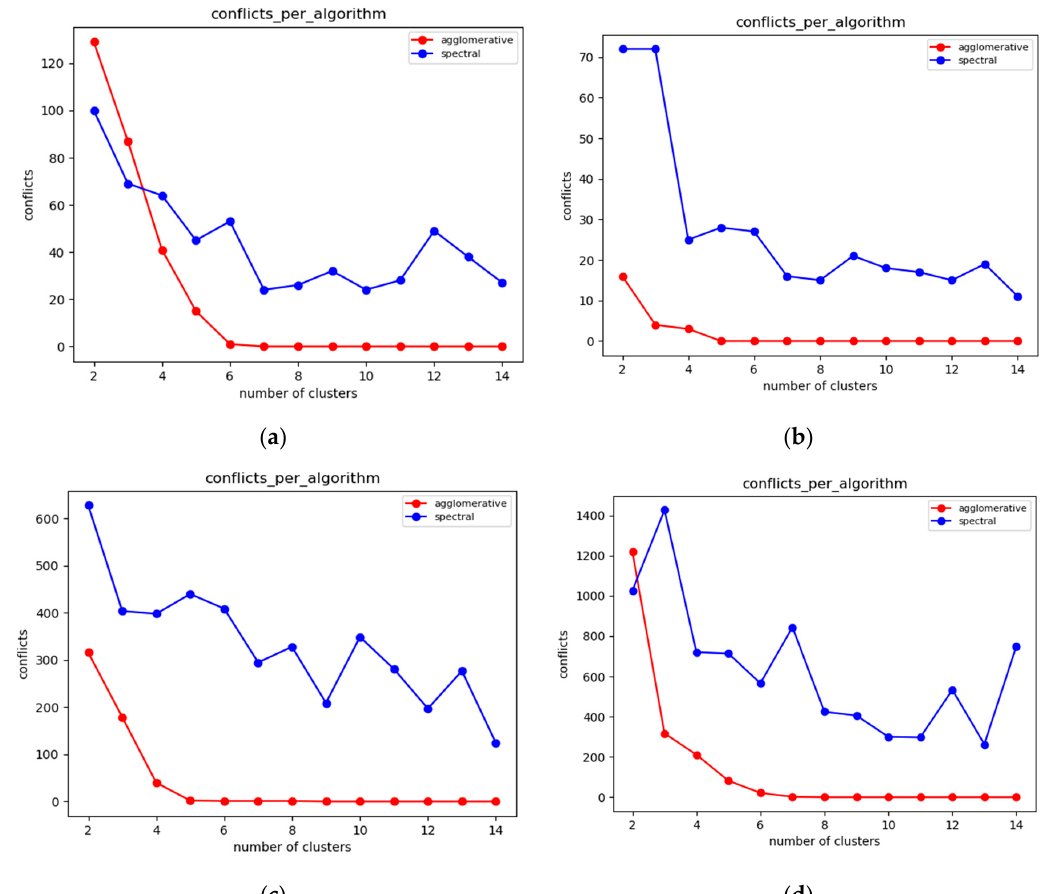
Figure 2. Comparison between constrained hierarchical agglomerative algorithm and constrained spectral algorithm ( a ) 37 nodes, r s = 3, a = 2, ann = 9.2, ( b ) 100 nodes, r s = 3, a = 0, ann = 1.4, ( c ) 100 nodes, r s = 4.5, a = 2.6, ann = 22.6, ( d ) 123 nodes, r s = 9, a = 8.2, ann = 29.9.